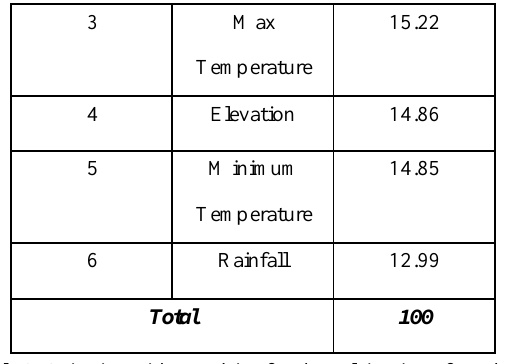
Table 3. Criteria weights ranking for the cultivation of sorghum;